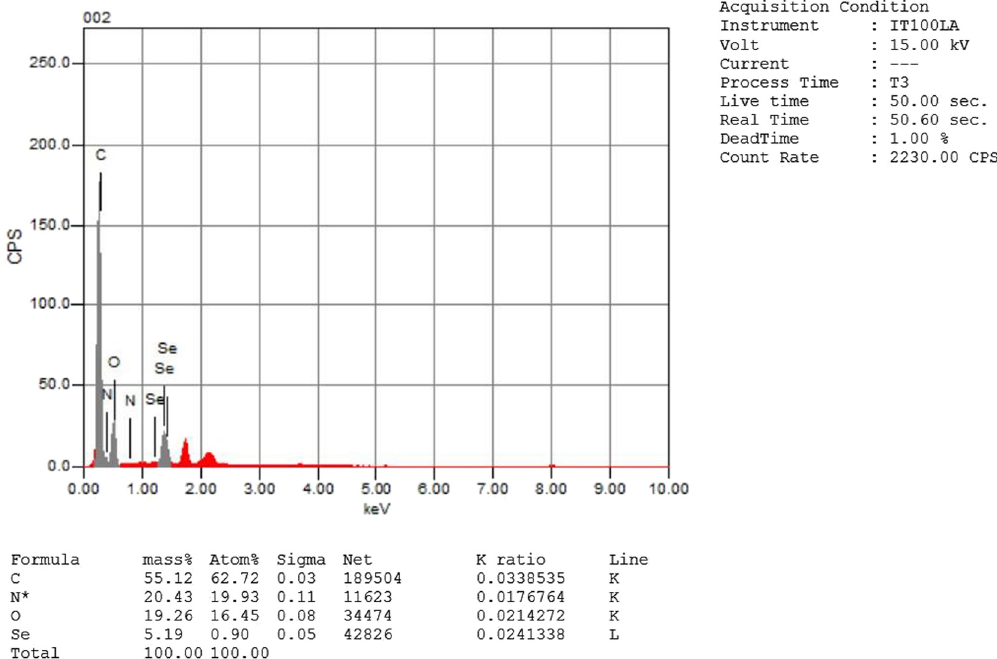
Figure 6: EDX analysis of Sp